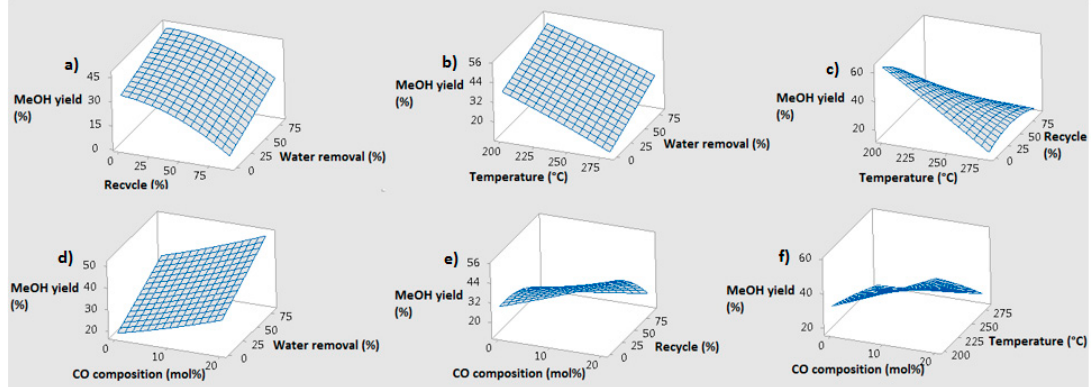
Figure 13. Methanol yield plots as function of analyzed factors (hold values: recycle 45%, temperature 240 ◦ C, water removal 40%, CO composition in the feed 10 mol %): ( a ) methanol yield as function of recycle and water removal; ( b ) methanol yield as function of temperature and water removal; ( c ) methanol yield as function of temperature and recycle; ( d ) methanol yield as function of CO composition in the feed and water removal; ( e ) methanol yield as function of CO composition in the feed and recycle; ( f ) methanol yield as function of temperature and CO composition in the feed.